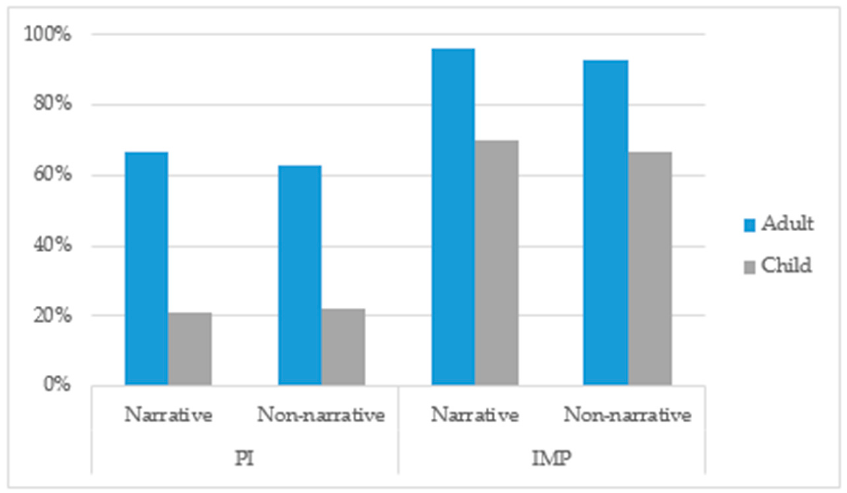
Figure 7. Proportion of target responses per age group and experimental setting for the C–O condi- tion.